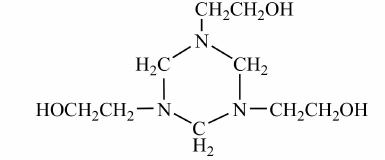
Figure 1. The structure of antibacterial additive. Table 3. Compositions of